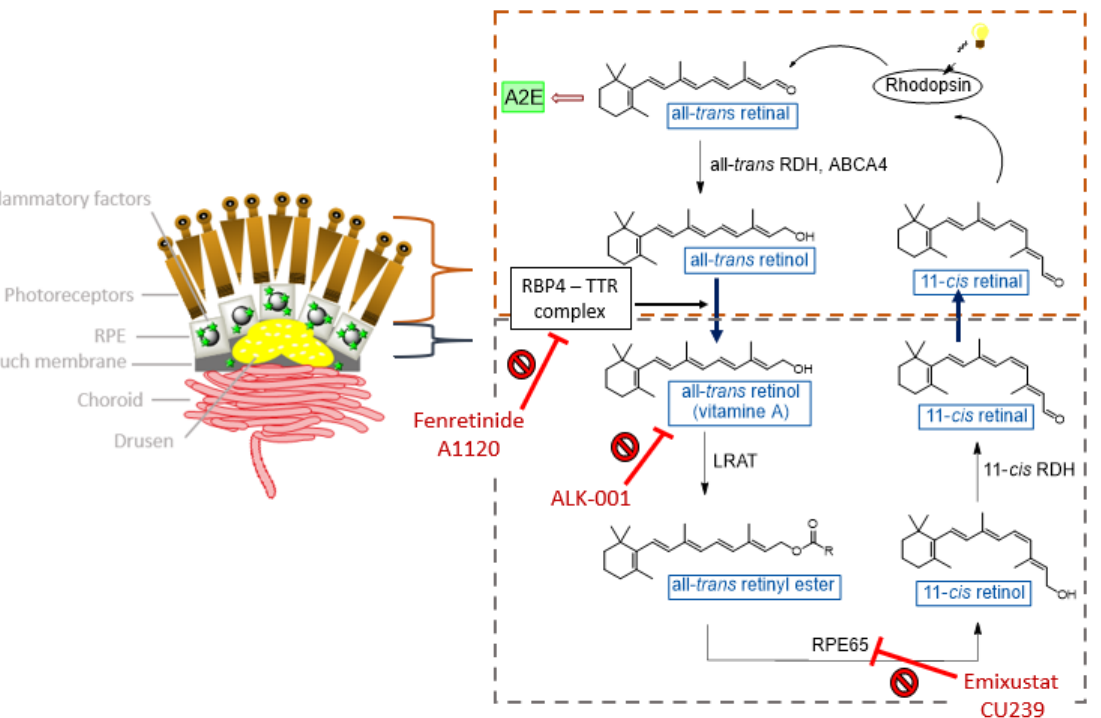
Figure 12. Visual cycle in the retina with AMD disease . A2E: N -retinylidene- N -retinylethanolamine;